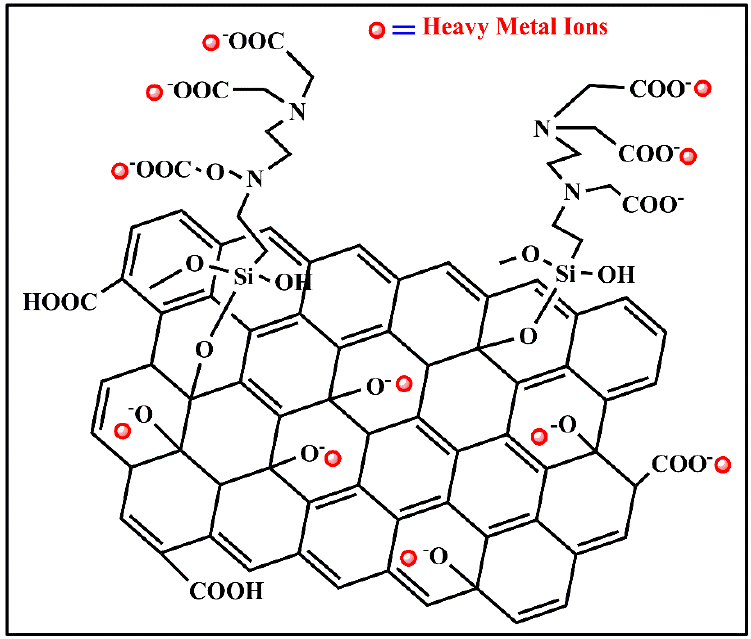
Figure 1. Heavy metal ions adsorption on EDTA-GO adduct surface [164].